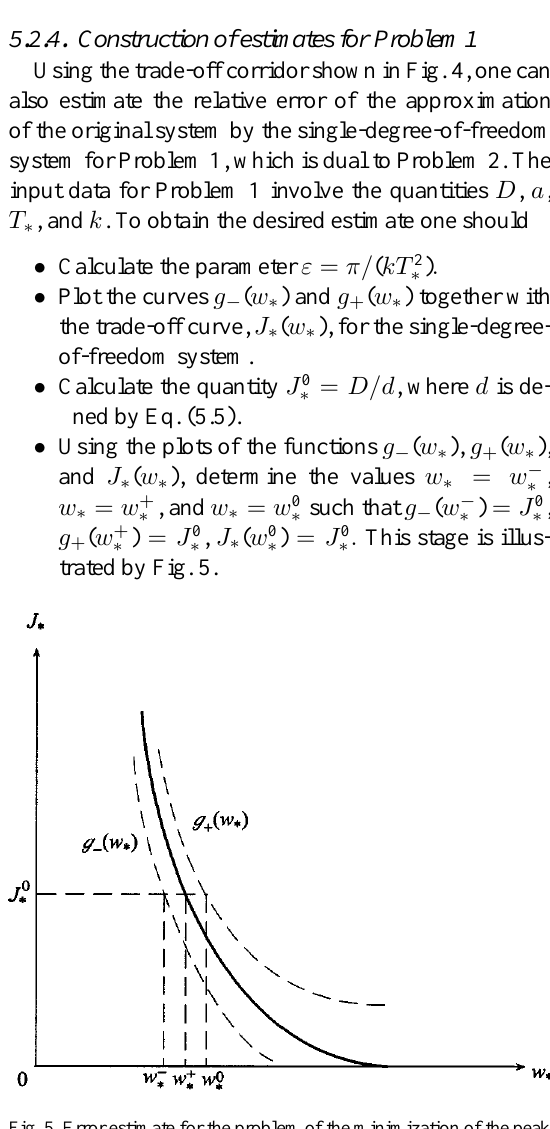
Fig. 5. Error estimate for the problem of the minimization of the peak value of the transmitted